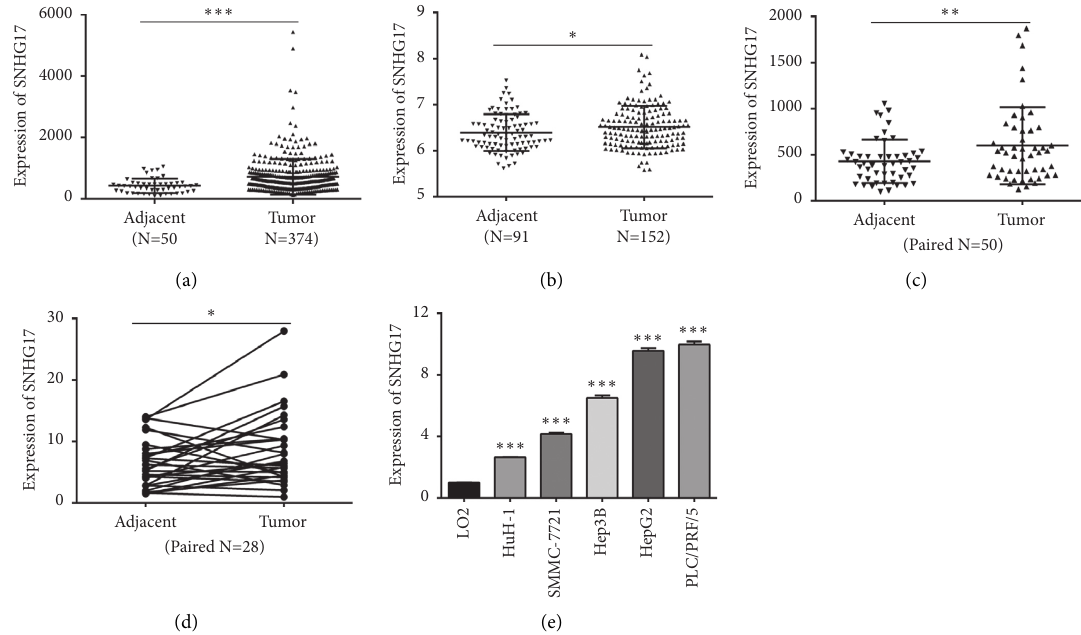
Figure 1: SNHG17 expression was upregulated in HCC tissues and cell lines. (a) SNHG17 was upregulated in HCC tissues ( n � 374) compared with adjacent tissues ( n � 50) in the TCGA-LIHC dataset. (b) SNHG17 was upregulated in HCC tissues ( n � 152) compared with adjacent tissues ( n � 91) in the GSE102079 dataset. (c) SNHG17 was upregulated in HCC tissues compared with corresponding non- tumorous tissues in the TCGA-LIHC dataset ( n � 50). (d) SNHG17 was upregulated in HCC tissues compared with corresponding nontumorous tissues ( n � 28), which was examined by qRT-PCR. (e) Expression levels of SNHG17 were examined in HCC cell lines and normal hepatic epithelium cell line (LO2). ∗ P < 0 . 05, ∗∗ P < 0 . 01, and ∗∗∗ P < 0 .